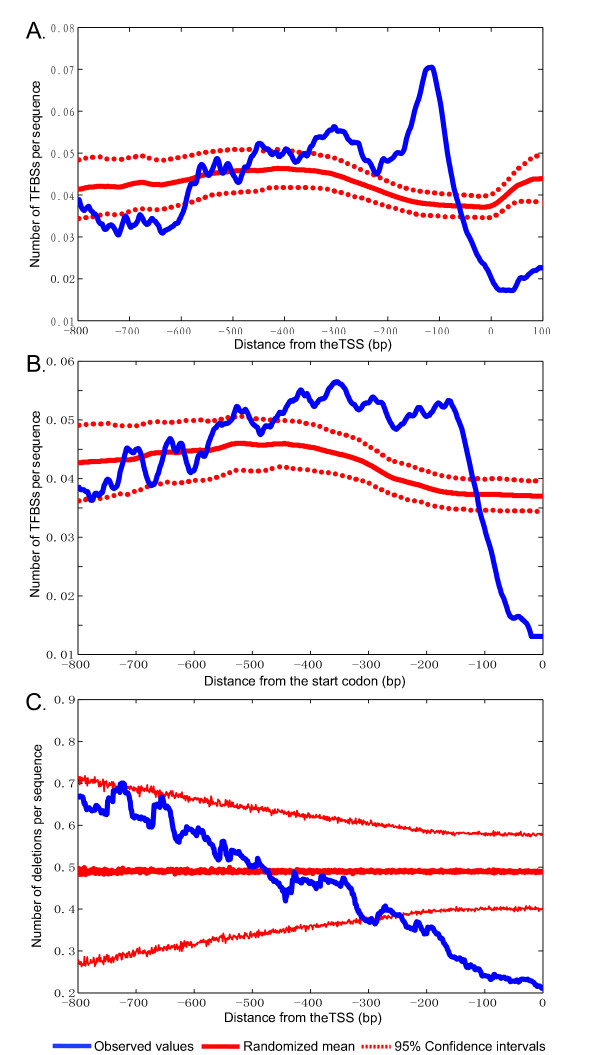
The distribution of TFBSs in yeast promoters. (A) The frequency distribution of the distances from the TFBSs to the transcription starting site (TSS) in genes. This figure shows the spatial distribution of TFBSs in the promoters of 4369 genes (using TFBS dataset IV). The value at each position relative to the TSS is a moving average of a window of 41 bp. The distribution has a very sharp peak ~115 bp upstream of the TSS and the TFBSs are strongly concentrated in the ~ 100 bp region from 180 to 80 bp upstream of the TSS. The blue solid line represents observed values; The red solid and dotted lines represent the mean of randomization and 95% confidence intervals for 1000 randomized tests (B) No sharp peak was found in the frequency distribution of TFBSs relative to the translation start codon. This figure was generated using the same data as in (A) except that the translation start codon instead of the TSS was used as the reference point. (C) The frequency of deletion polymorphisms in the TSS-proximal region is the lowest in the promoter region and is significant lower than random expectation. This figure was generated using the same data as in (A).